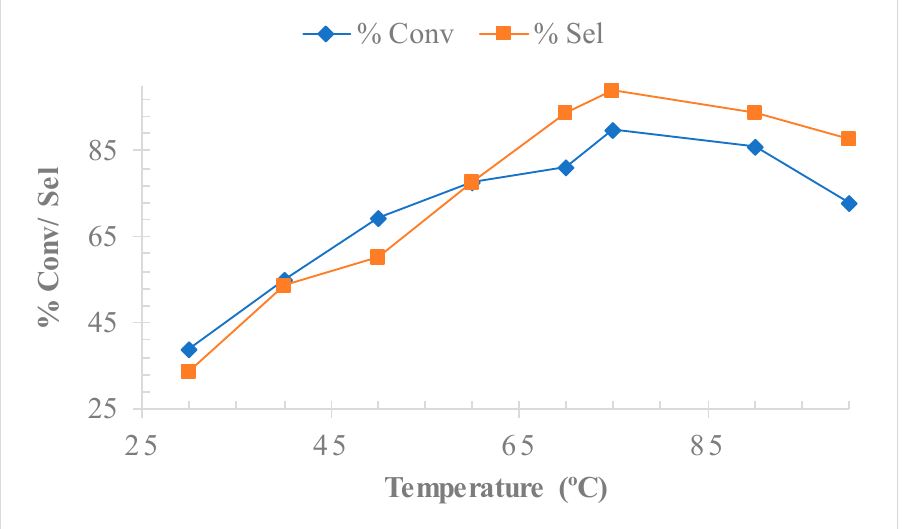
Figure 5. Effect of temperature on percent conversion and selectivity of CA to CD in the presence of Ag-Co/S. Conditions of reaction: Cat; 25 mg, CA; 1 mmol in 10 mL solvent, Solvent; ethanol, Oxidant; O 2 (1 atm), Time; 80 min, Stirring speed; 750 rpm.